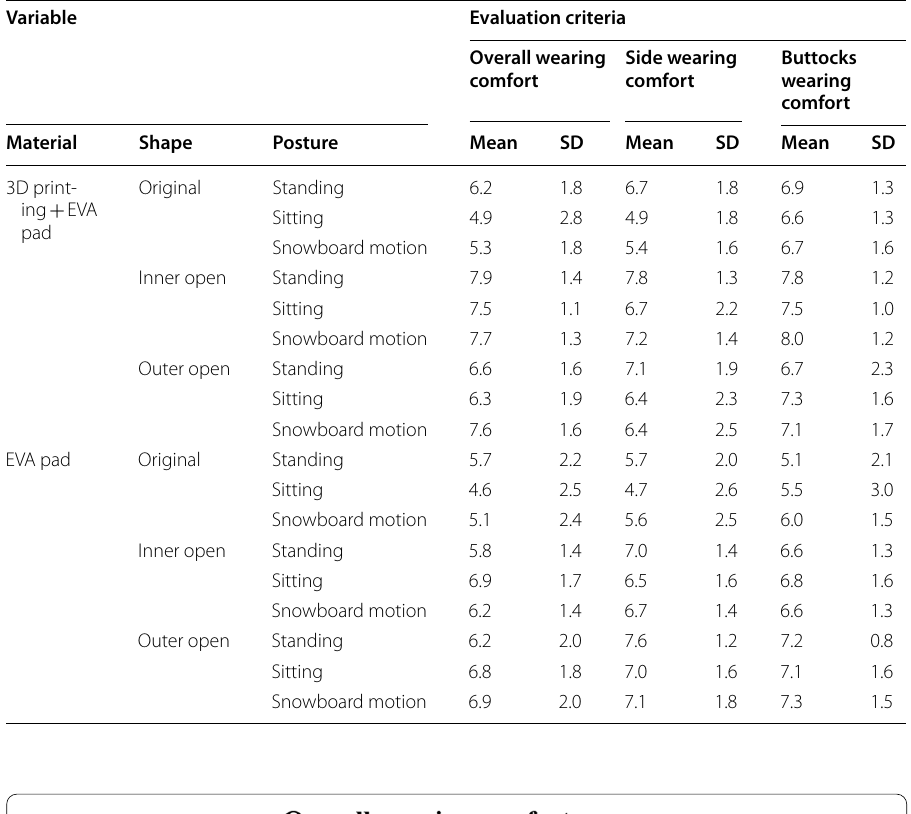
Table 3 Mean and SD of subjective comfort depending on material, shape, and test posture (N 10) =